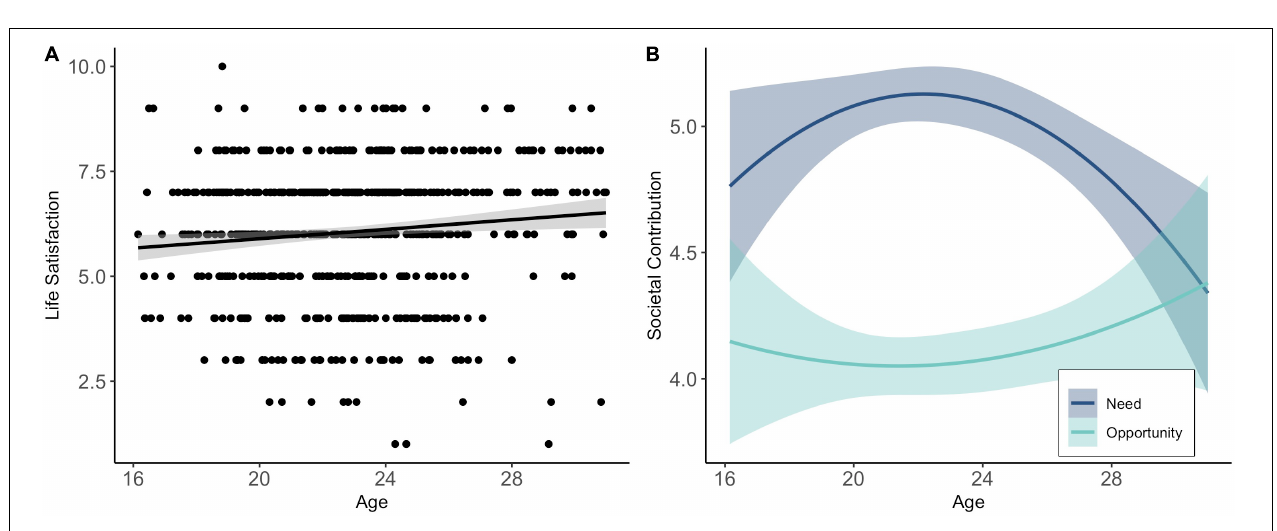
FIGURE 5 | Linear age effects on life satisfaction during COVID-19 (A) and quadratic age effects on need and opportunities for societal contribution during COVID-19 (B).